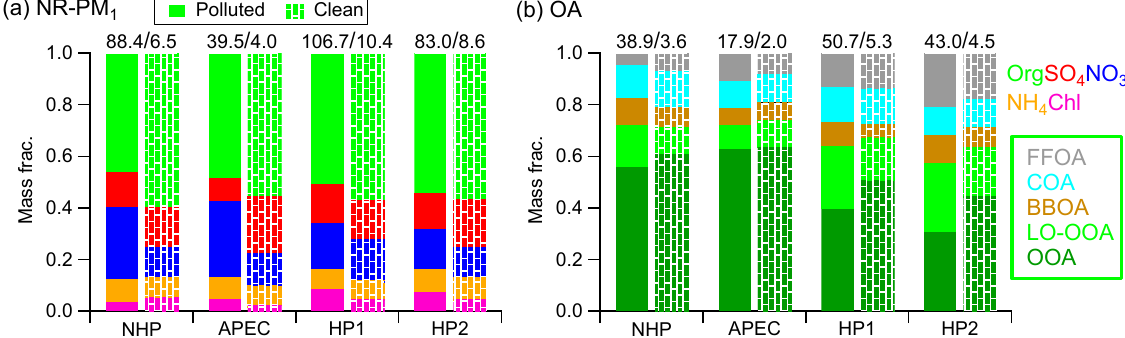
Figure 10. Comparisons of the chemical composition of (a) NR-PM 1 and (b) OA between the clean periods and polluted episodes that are marked in Fig. 1 during the four different periods, i.e., NHP, APEC, HP1, and HP2. The numbers on the top of the bar graphs are the average mass concentrations of NR-PM 1 and OA.